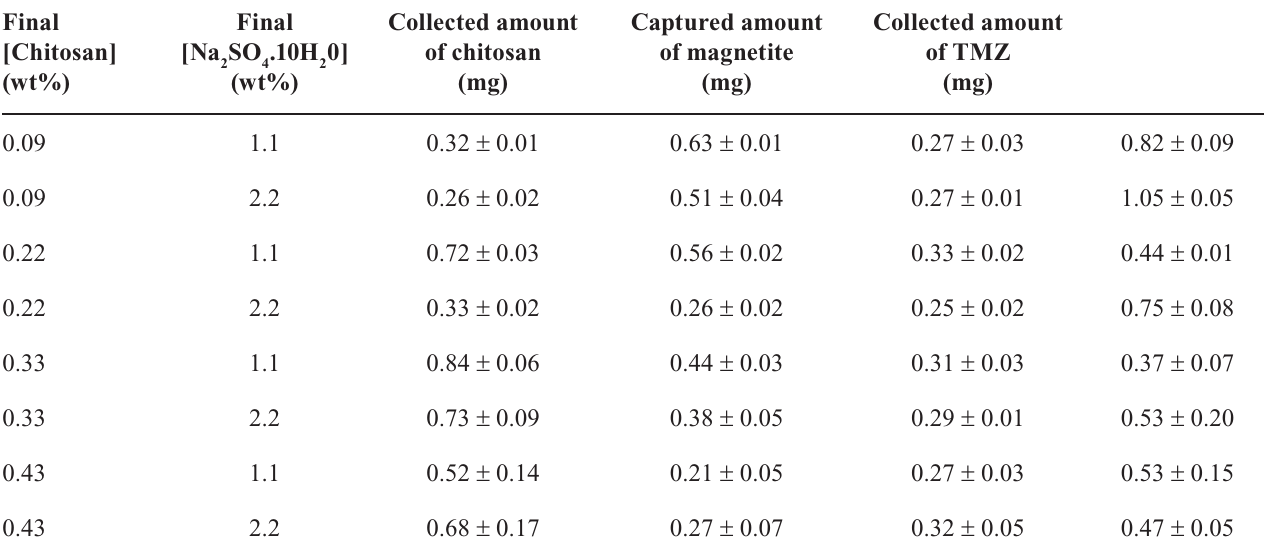
TABLE IV - Targeting study with Section II (applying 0.5 T magnetic